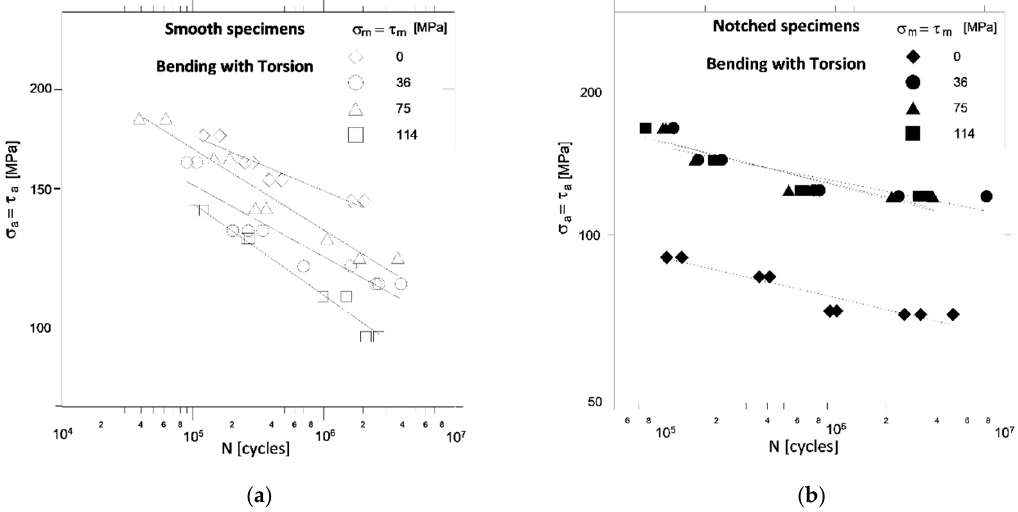
Figure 5. Comparison of fatigue characteristics of smooth ( a ) and notched ( b ) specimens under combined bending with torsion and different values of mean stress.